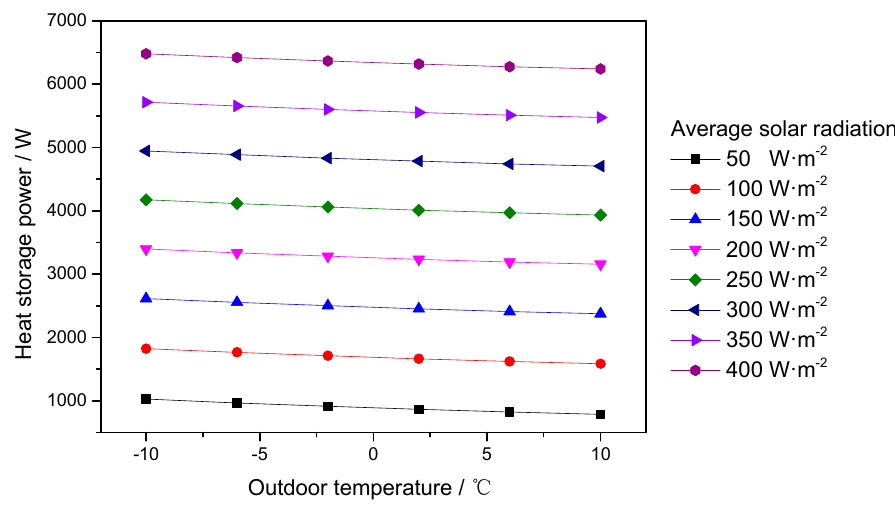
Figure 3. Relationship between the heat storage power of the solar attic and the outdoor meteorological conditions.